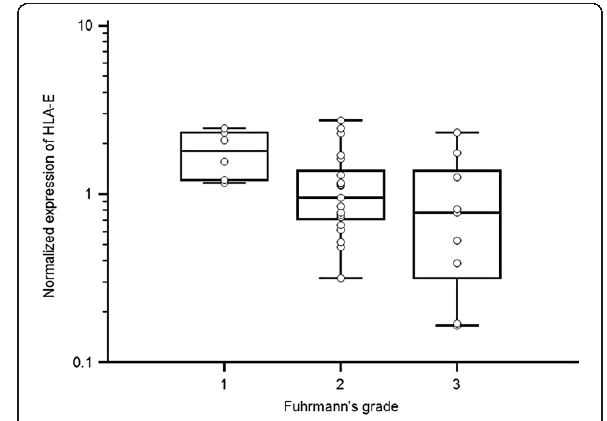
Figure 4 Relapse-free survival of RCC patients based on the HLA-E expression (cut off=25th percentile of HLA-E expression levels in RCC tissue; p=0,0115, Long-rank test).